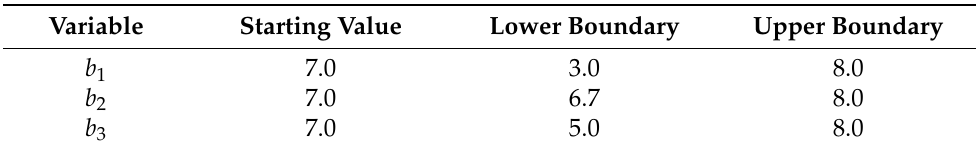
Table 2. Starting values and boundaries for the optimization variables b j estimated by adapting the electrochemical reactor model to measured